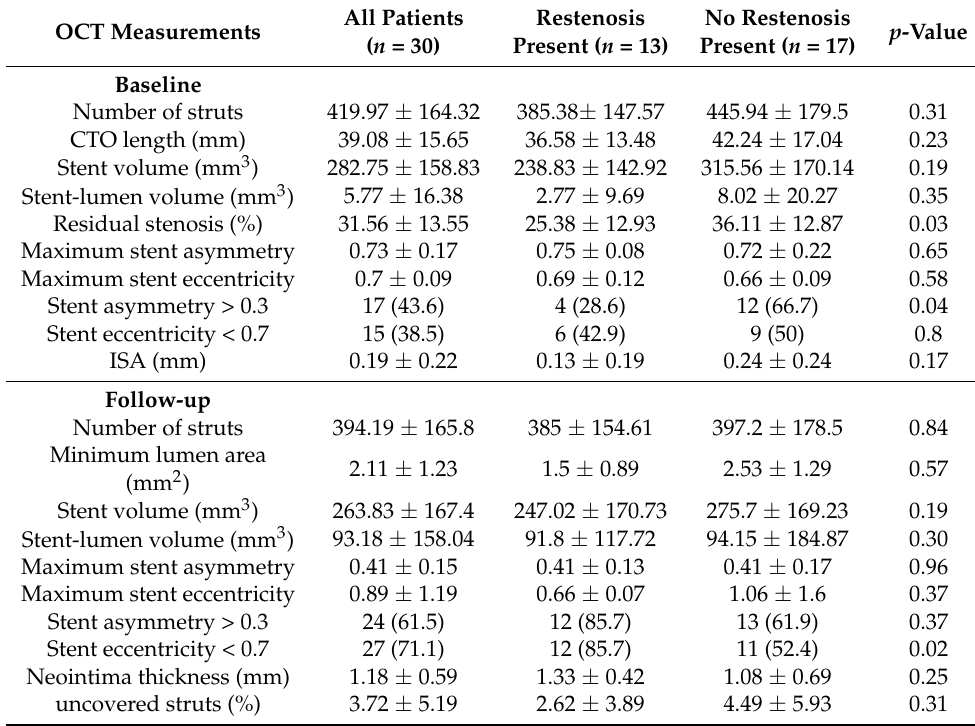
Table 3. Results of quantitative OCT assessment at